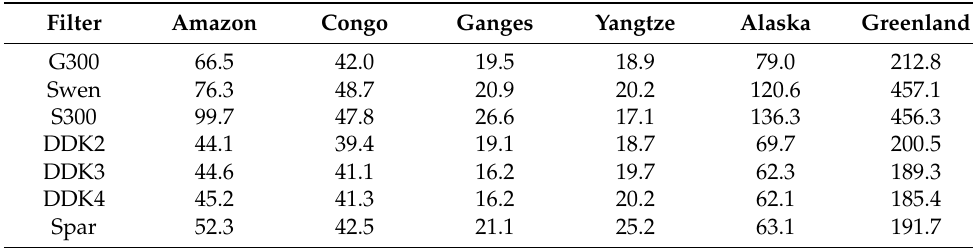
Table 2. The RMSD of the regional total mass anomaly of different filtered solutions with respect to mascon solutions. The results are calculated from the right panel of Figure 5.